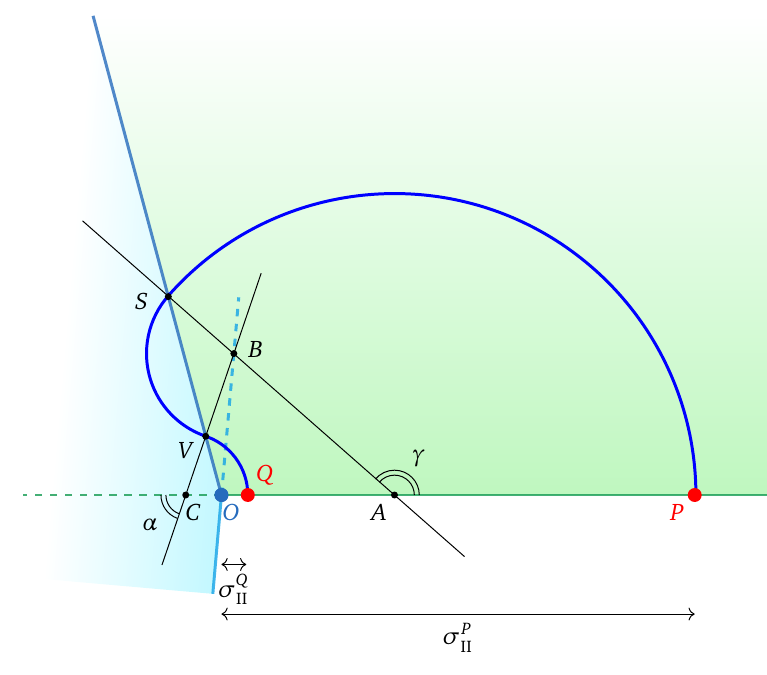
Figure 6: Geometric construction to find geodesics that explore the space behind the brane. The point O refers to the origin where the defects lies, not one of the boundary points of the